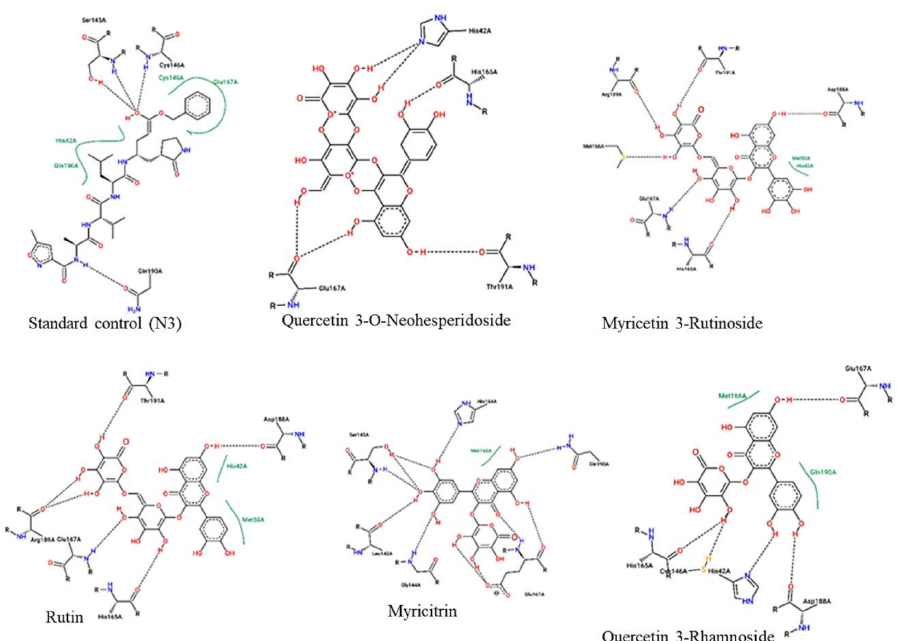
Figure 1. 2-dimentional protein–ligand interactions created for docked ligands and N3 into the active site of M pro ranked according to their binding energies. Black bond interactions showed H-bonds between the atoms of the ligands and the residues of the receptor.